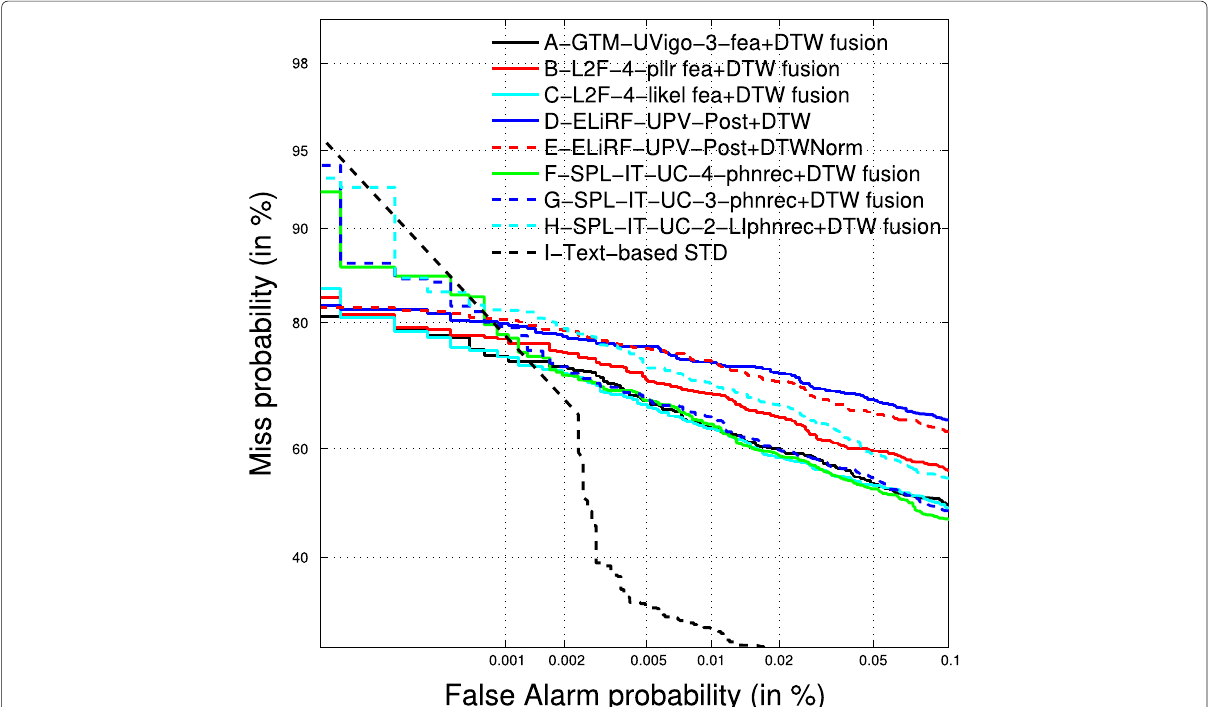
Fig. 7 DET curves of the QbE STD and the text-based STD systems on the MAVIR test